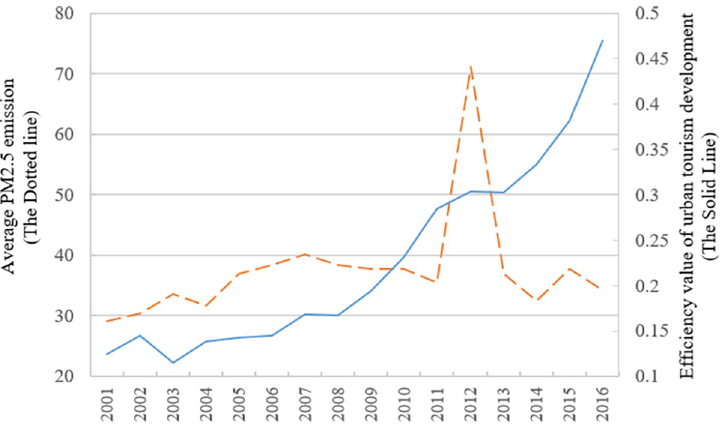
Fig 2. Variation of the efficiency of urban tourism development and PM2.5 emissions in 2001–2016.